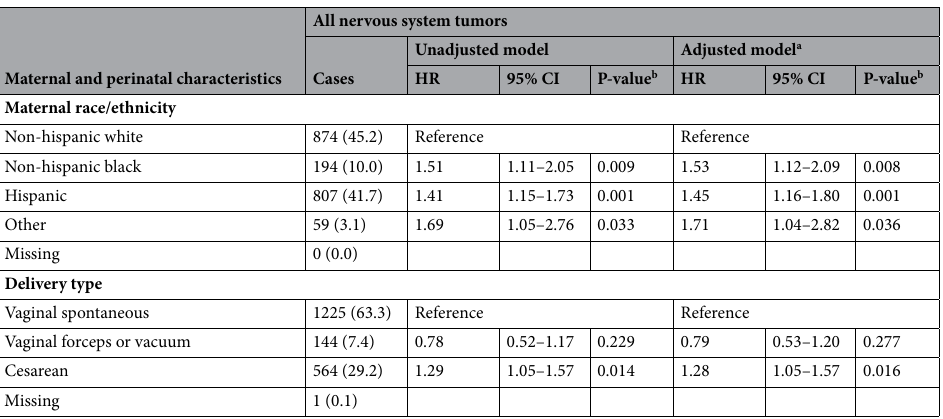
Table 4. Significant associations between maternal and perinatal factors and survival of pediatric central nervous system tumor cases. a Adjusted for birth year, sex, maternal race/ethnicity, maternal education, and tumor malignancy. b Bonferroni corrected reference P values: 0.003 for an experiment-wide significance of 0.05.